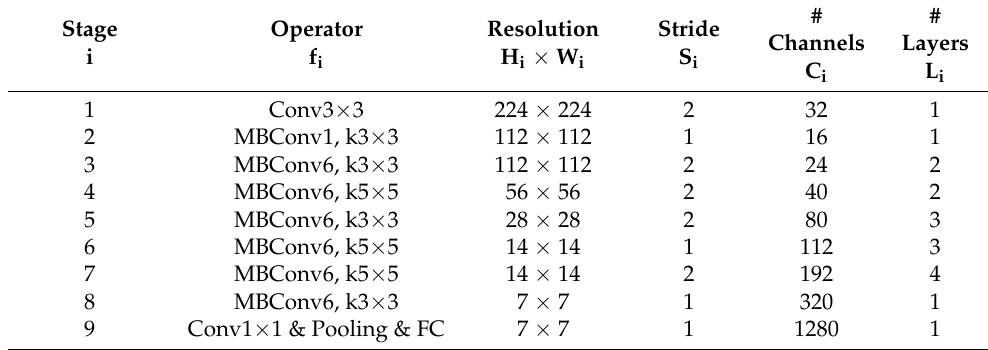
Table 1. EfficientNet-B0 baseline network structure.